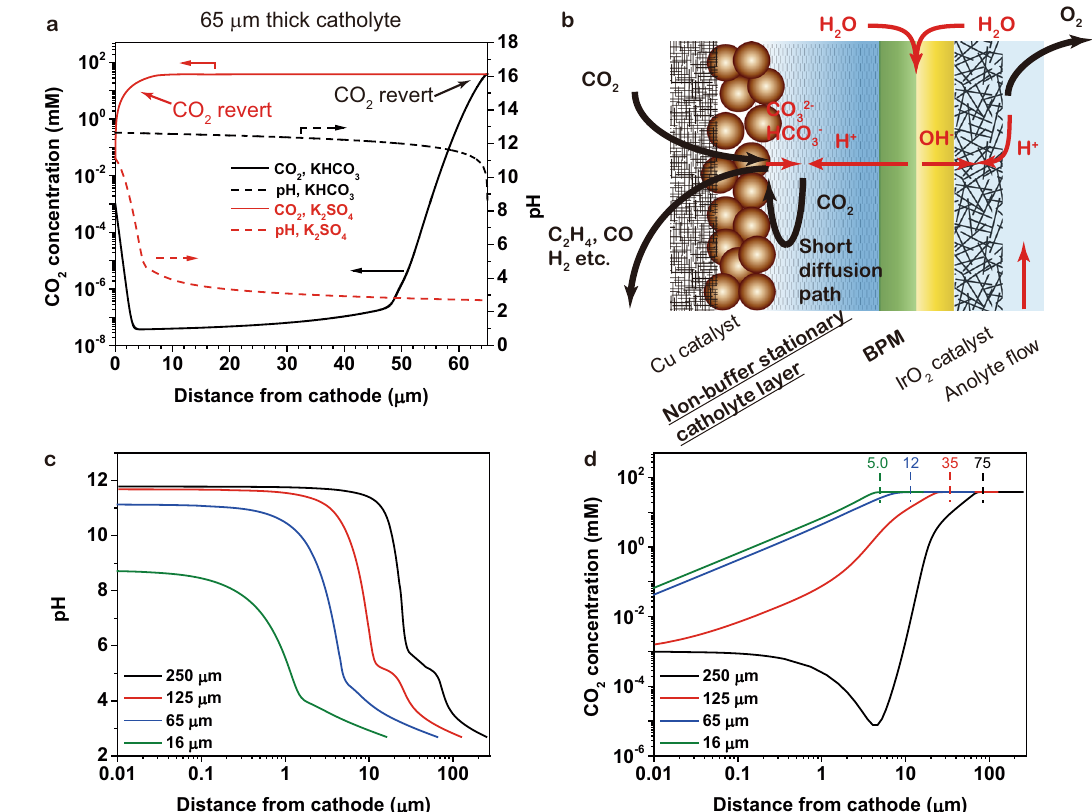
Fig. 1 The con fi guration and simulation of the electrolyzer design. a The CO 2 (solid lines) and pH distributions (dashed lines) in the 65 μ m-thick SC- layer. The positions where the (bi)carbonates revert to CO 2 are marked (red for non-buffering and black for buffering electrolyte). b The schemes and the mass transfer in the SC-BPMEA. c The pH distribution inside the SC-layer. d The dissolved CO 2 concentration pro fi le inside the SC-layer. The virtual boundaries marked by dash lines are de fi ned as the position where the CO 2 concentration becomes 1% lower than the bulk concentration. The numbers marked above are the distances between the virtual boundaries and the cathode